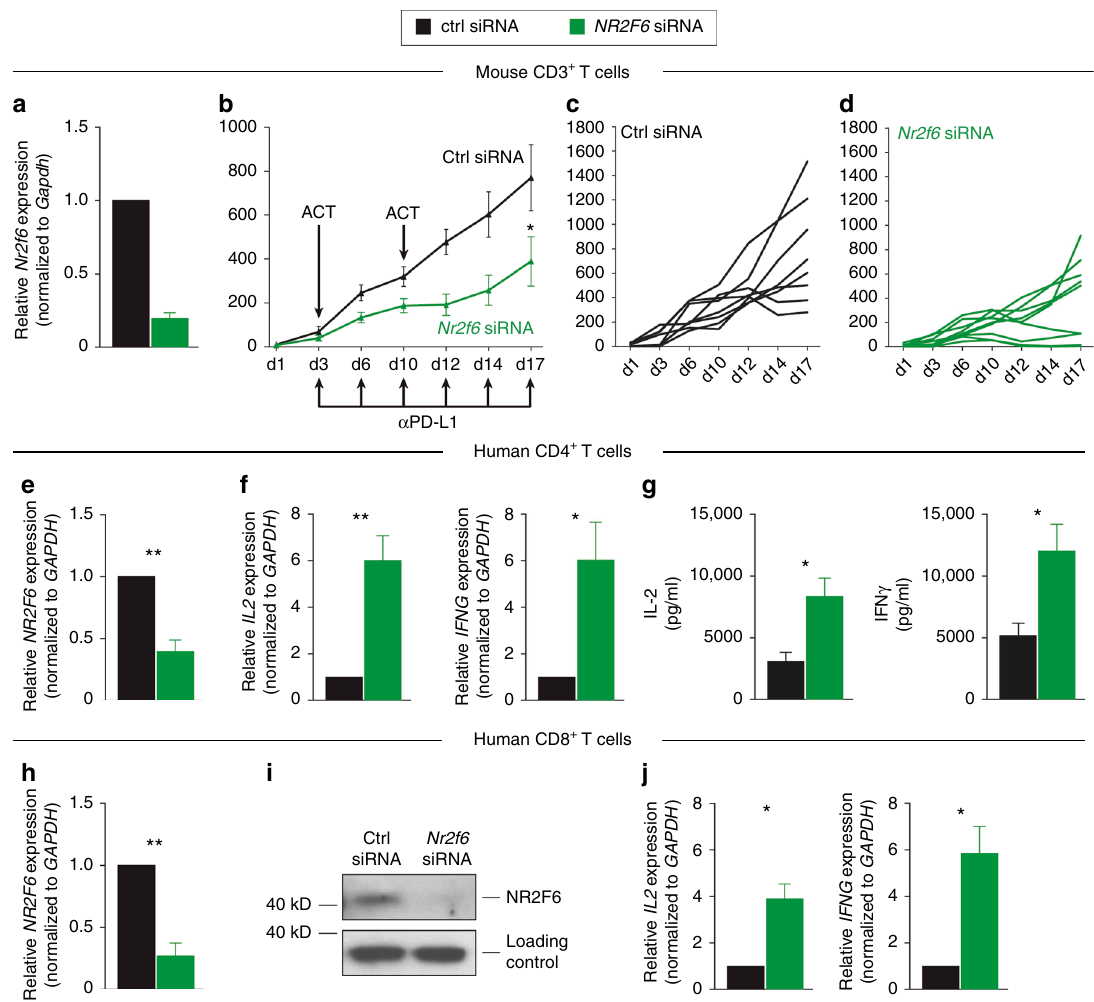
Fig. 5 Nr2f6 gene silencing is effective and leads to hyper-responsiveness of T cells. a − d Tumor growth effects depend primarily on NR2F6 function in CD3 + T cells. a Mouse Nr2f6 gene silencing is effective in CD3 + T cells ( p = 0.002, unpaired t -test). Mouse CD3 + T cells were nucleofected with Nr2f6 siRNA or control siRNA as indicated. Silencing ef fi cacy of Nr2f6 siRNA was analyzed by qRT-PCR and normalized to Gapdh ( n = 3). b − d Wild-type recipients received 5×10 5 MC38 tumor cells s.c. and were treated with therapeutic adoptive cell transfers (ACT) of 1×10 7 CD3 + T cells transfected with control (black, n = 8) or Nr2f6 (green, n = 8) siRNA on d3 and d10 after tumor injection ( p = 0.0172, ANOVA). Mice were also treated with 0.25 mg of antibody against PD-L1 (Ab10F.9G2) on the respective days. Single tumor growth curves of wild-type mice receiving ACT of c control siRNA transfected CD3 + T cells or d Nr2f6 siRNA silenced CD3 + T cells. In the Nr2f6 siRNA ACT group, one mouse (11.1%) was able to reject the high tumor burden completely, but all mice of the control siRNA ACT group had to be killed latest on d19. e − j Human CD4 + and CD8 + T cells were nucleofected with NR2F6 siRNA or control siRNA as indicated ( n = 3). Silencing ef fi cacy of Nr2f6 siRNA was analyzed by qRT-PCR ( e CD4 + p = 0.0037, h CD8 + p = 0.002)